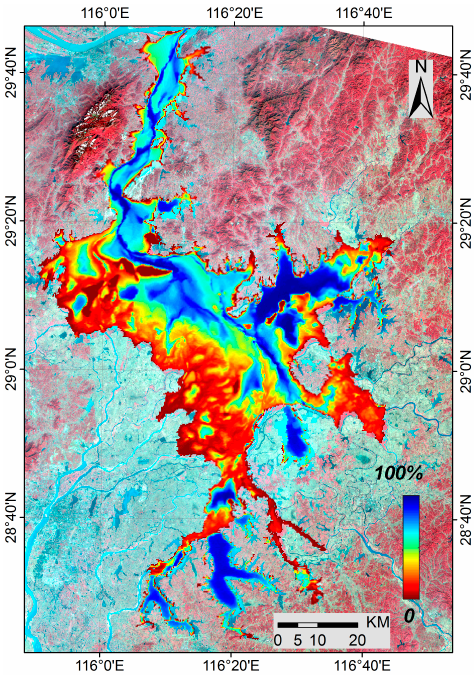
Figure 10. Monthly water surfaces for the Poyang Lake in 2011 (drought year). Lake surfaces are derived using the MinVC NDVI.